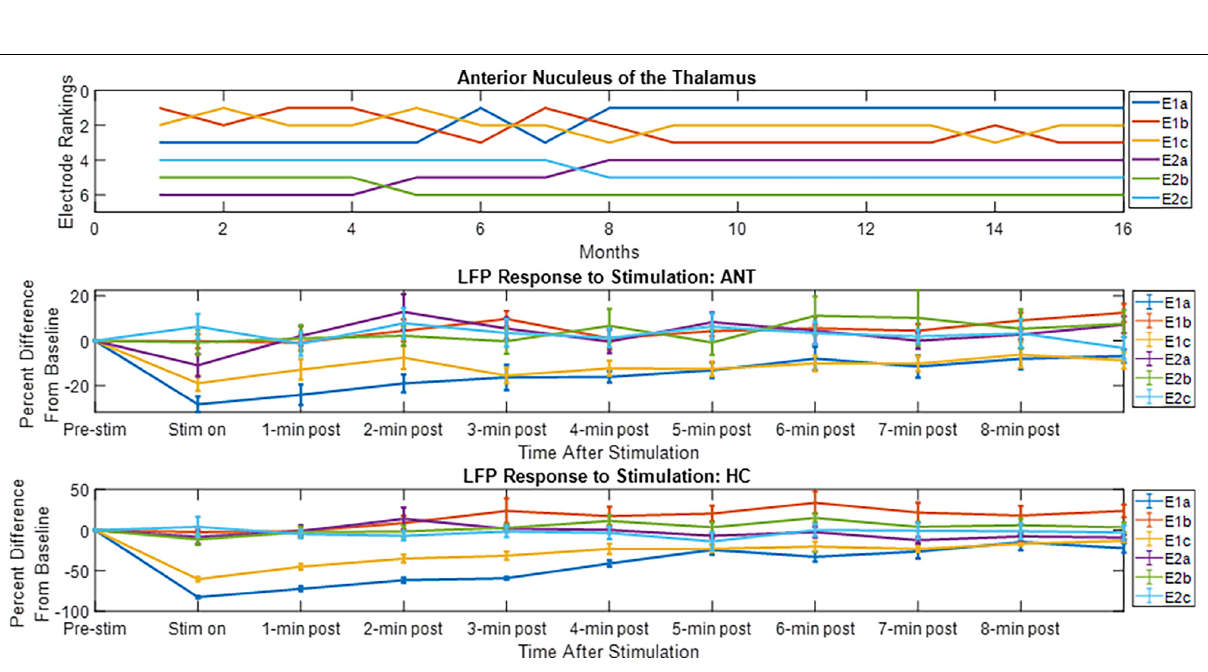
Frontiers in Human Neuroscience | www.frontiersin.org